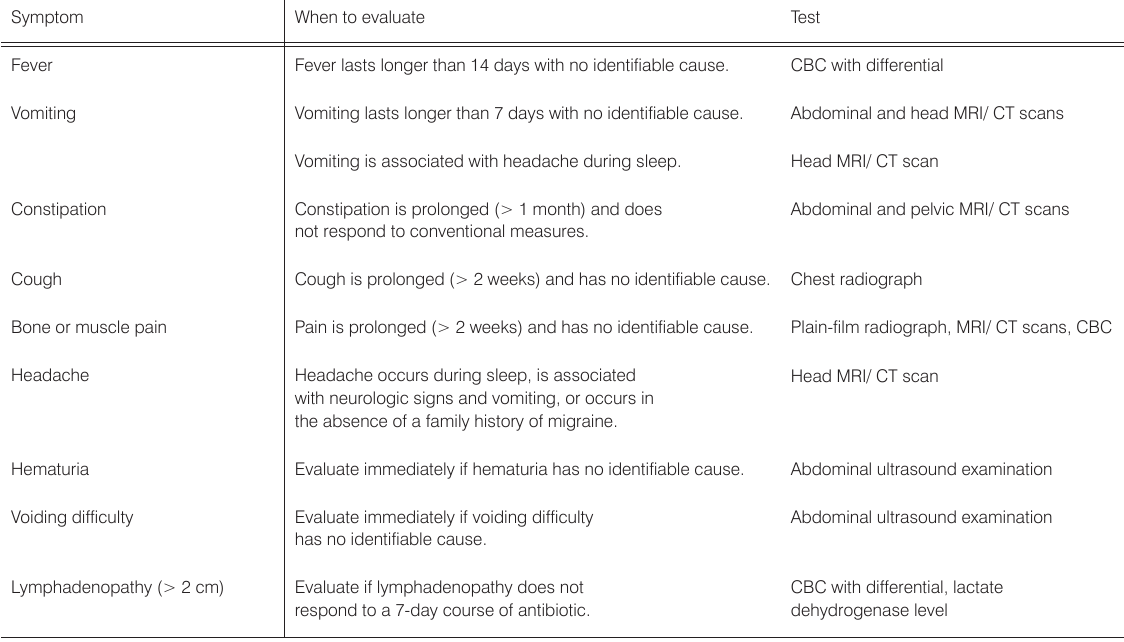
Table 3. When and how to evaluate symptoms for cancer [ 24 ]